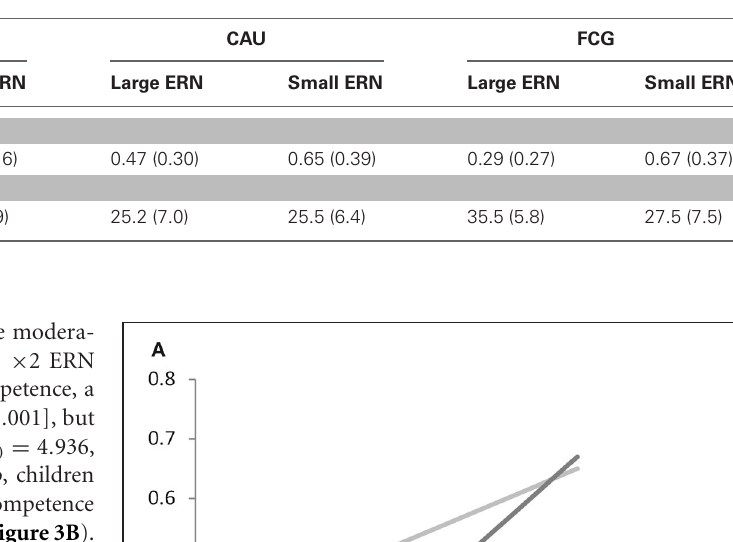
Table 2 | ANOVA moderation means.